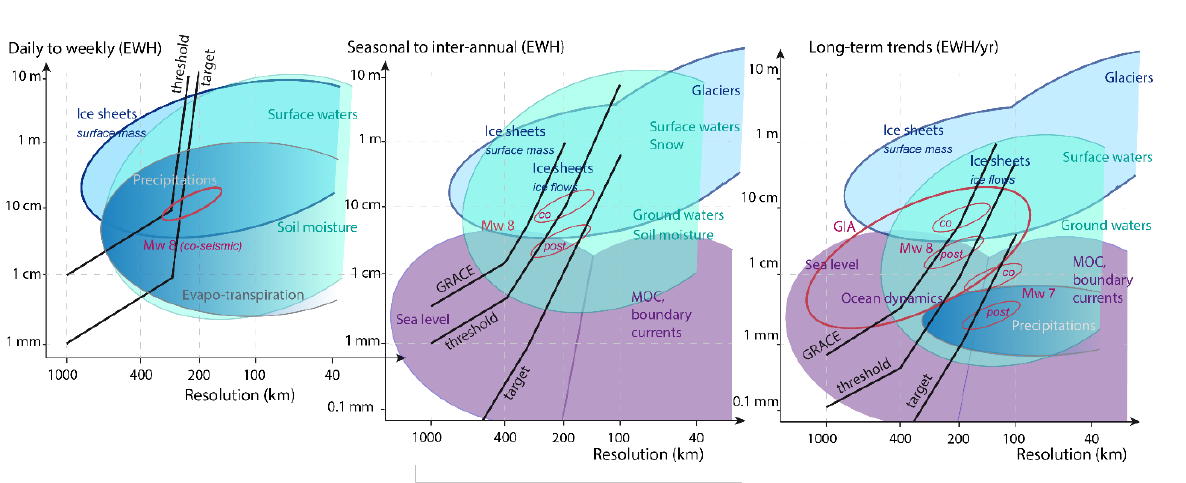
Fig. 1. Signal amplitudes of mass variations in equivalent water height (EWH) as a function of spatial resolution, together with present- day accuracy and resolution (GRACE) and with MOBILE threshold and target performances. Solid Earth mass variations are converted to EWH. Contributions from daily to weekly variations (left panel), from seasonal to inter-annual variations (middle panel), and from long-term trends (right panel). Drawn from (Pail et al.